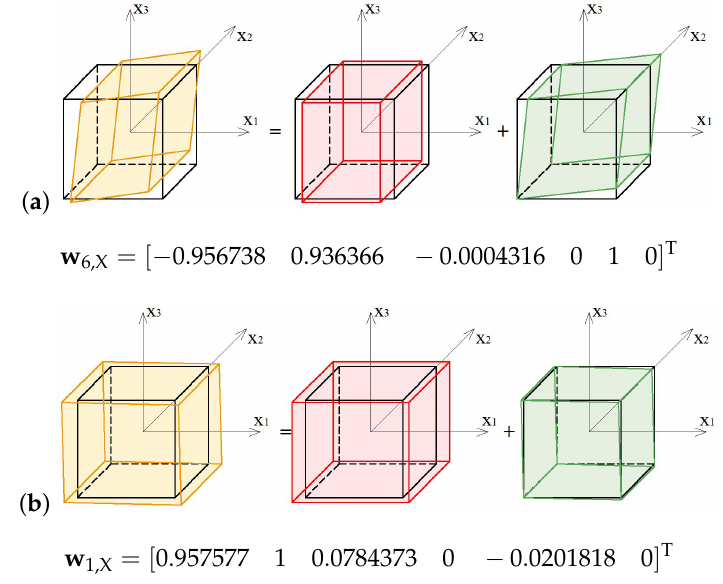
Figure 18. Deformation modes of the X-module: ( a ) Soft mode. ( b ) Stiff